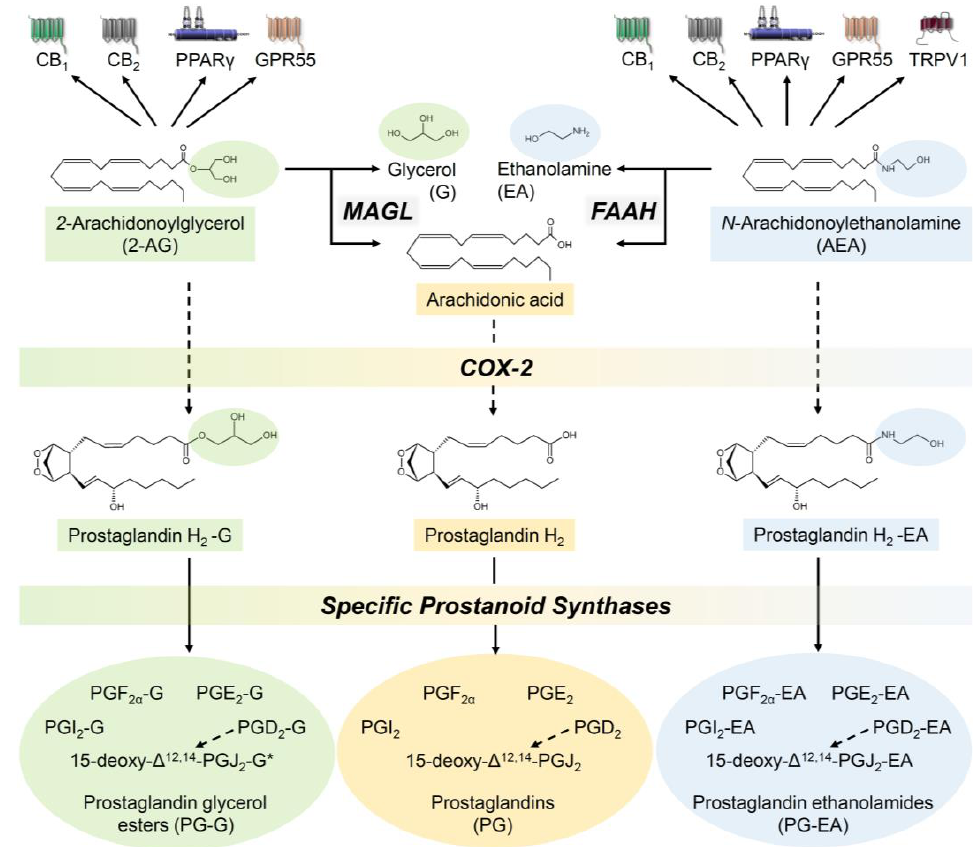
Figure 1. Degradation of AEA and 2-AG by FAAH, MAGL and COX-2 to analytically detectable or putative (*) metabolites. The arrows indicate activations or inductions. Dashed arrows show that various intermediate steps in the metabolism lead to the next parameter. All abbreviations are given in the text.